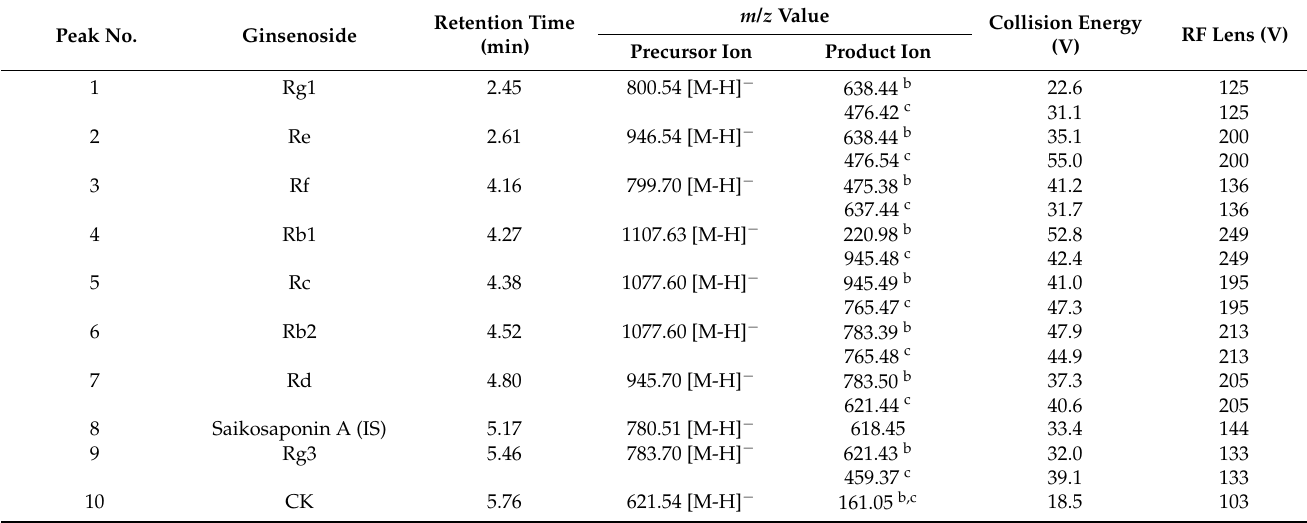
Table 6. The precursor ion, product ion, collision energy, and radiofrequency (RF) lens conditions of 10 ginsenosides by UPLC-HRMS-MS/MS a .